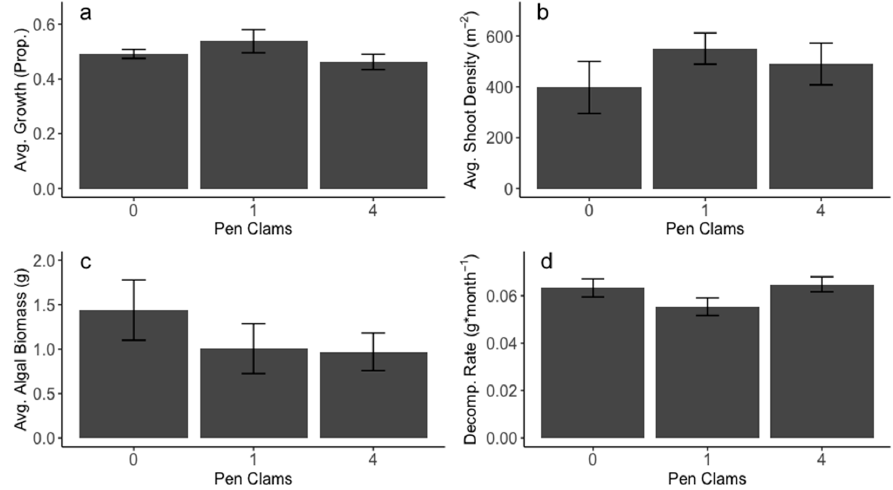
Figure 3. Ecosystem function responses from density-dependent pen clam transplant experiment. ( a ) Average proportional growth of seagrasses, ( b ) average seagrass shoot density per m 2 , ( c ) average algal biomass per m 2 , and ( d ) decomposition rate (g/month).